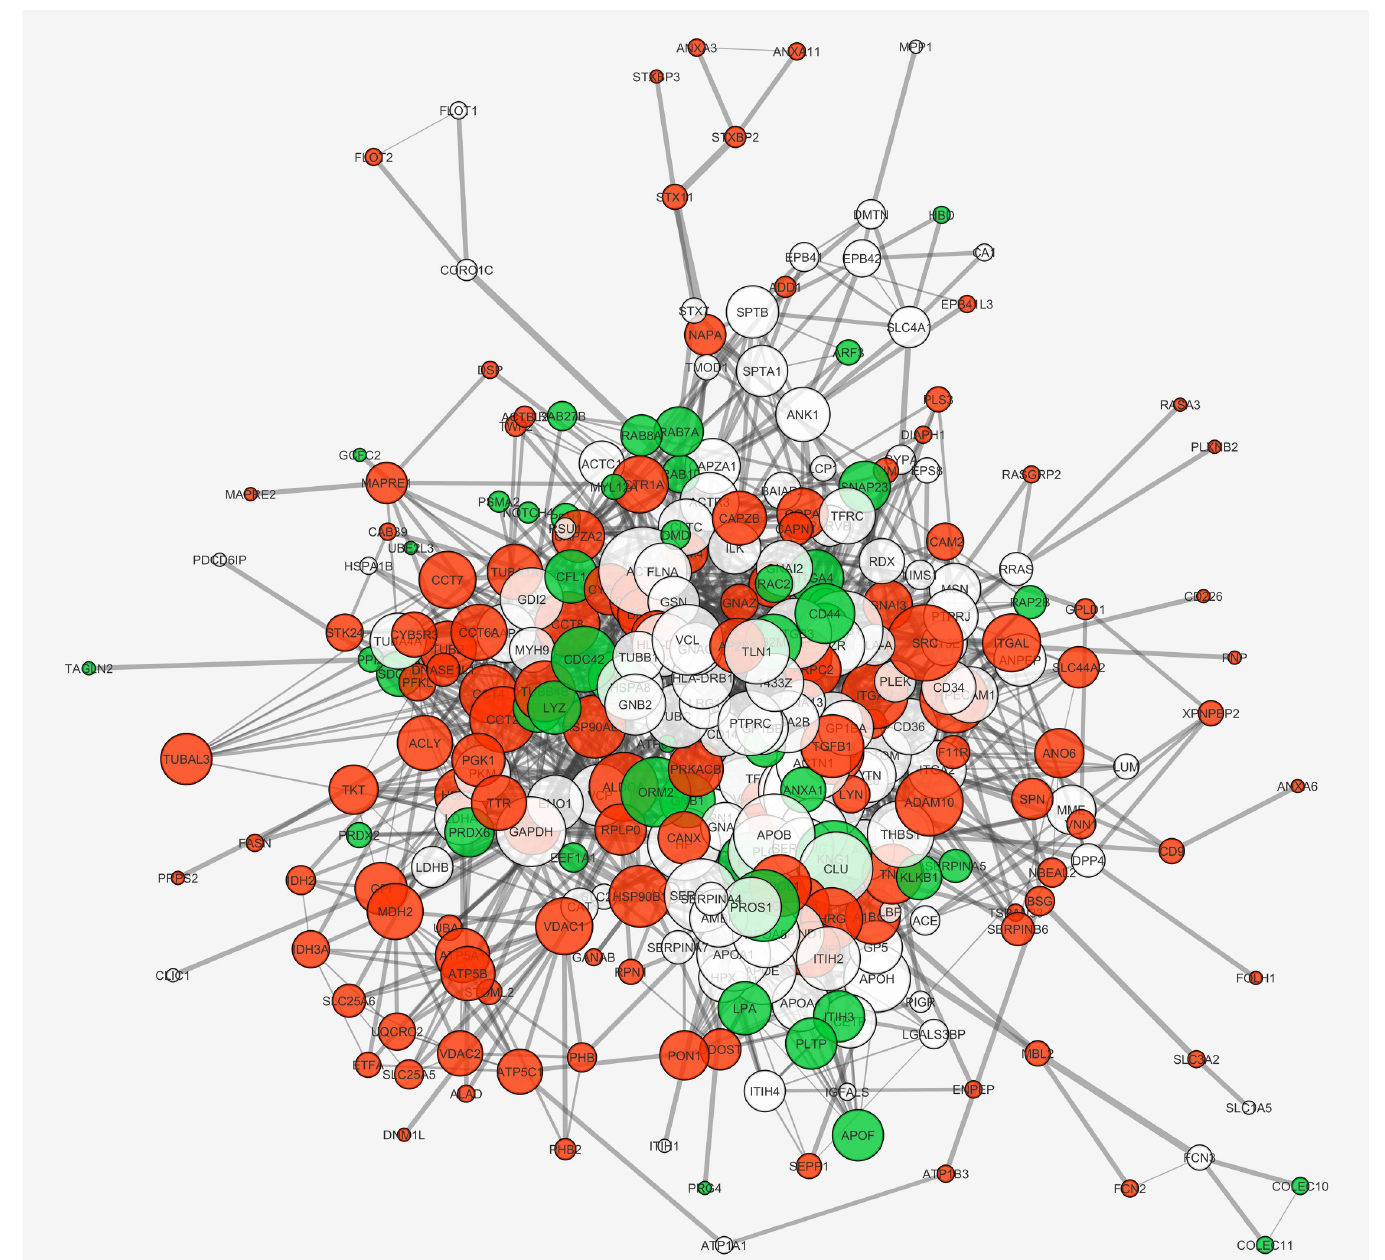
Fig 7. Dynet network. The APhs and IPhs networks were superimposed in one graph by the use of the Dynet application, to highlight patient group-specific and shared central proteins. Proteins identified only in samples from individuals with active CE are coloured in red, proteins identified only in inactive CE samples in green, and proteins identified in both samples in white. The node degree (number of interactions) is visualized by node size and the edge score (confidence of node interaction) is directly proportional to the edge size. On the right side are clearly visible the central hubs of APhs network, i.e. the proteins Src, TGF- β and the integrins α M , α V, α L (ITGAM, ITAV,